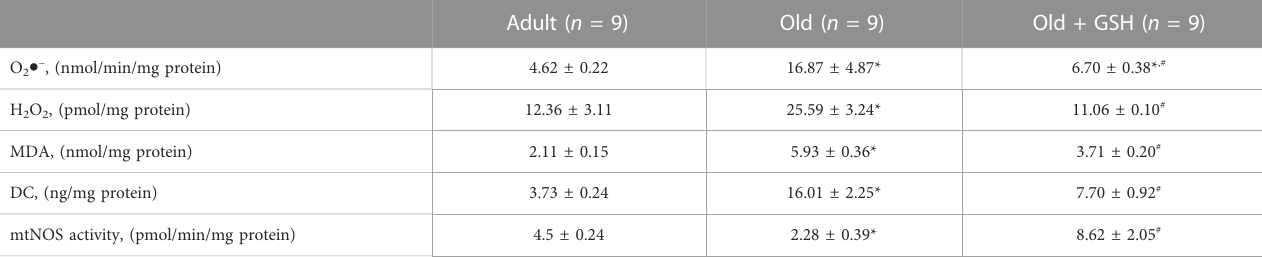
TABLE 2 Oxidative stress markers and mitochondrial NO synthase (mtNOS) activity in heart mitochondria of adult, old and GSH-treated old